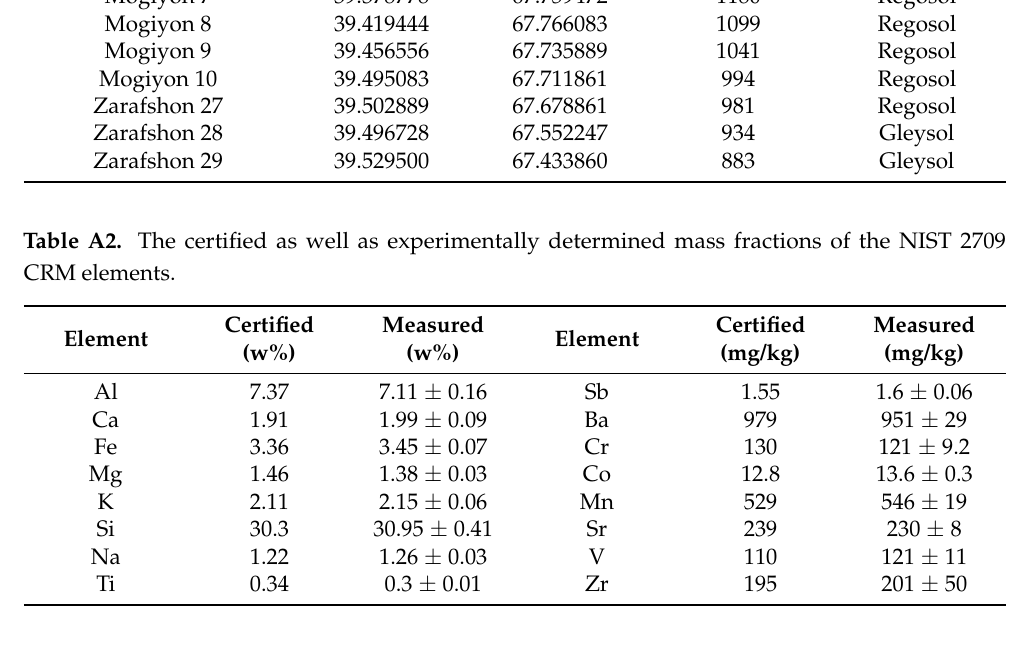
Table A3. The matrix of Spearman’s correlation coefficients of major elements (as oxides) in soils and sediments. All correlations significant at p < 0.05 are represented in red (positive correlation) or blue (negative correlation)